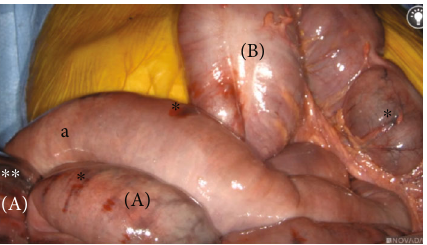
Figure 1: White light view of small intestines (a) and large intestines (b) with patchy ischemia ( ∗ ) and necrosis ( ∗∗ )